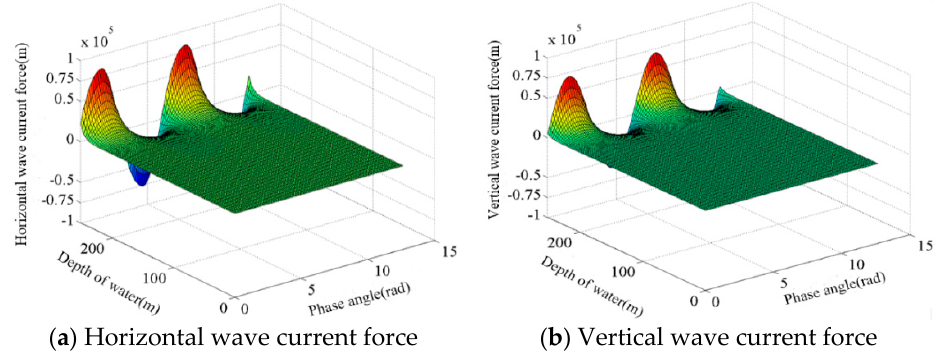
Figure 9. Variation of clamp wave flow force on horizontal steel pipe with water depth and phase angle.